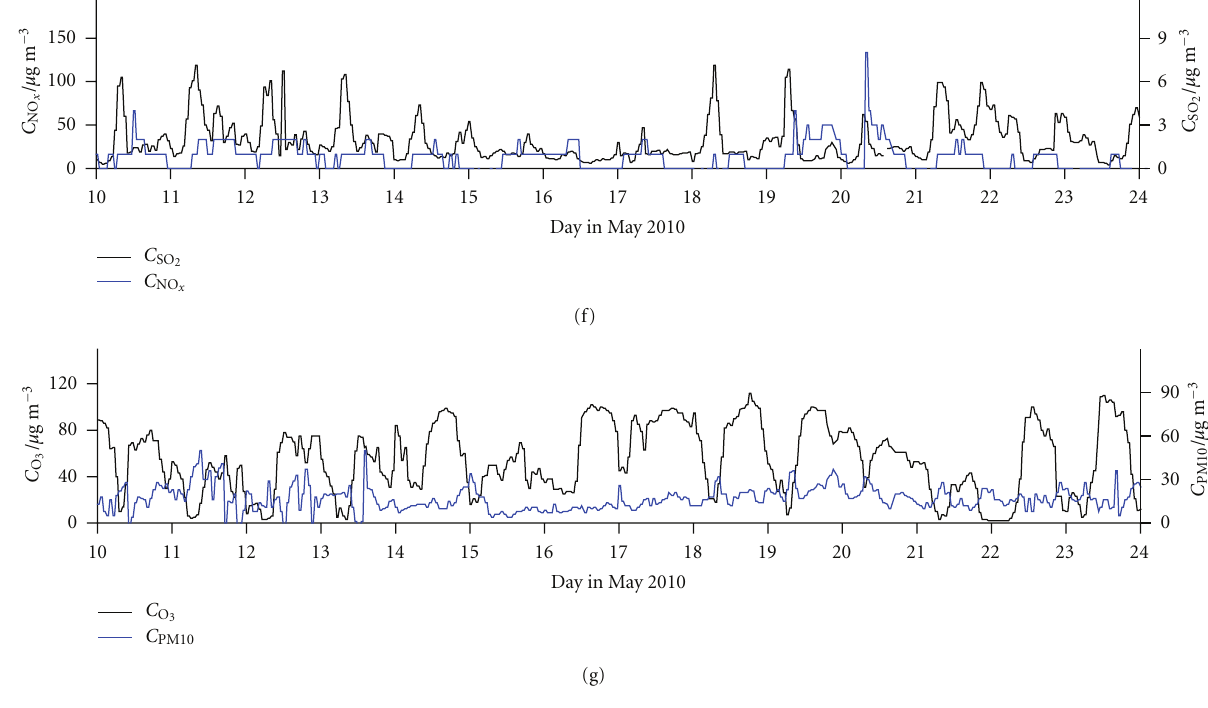
Figure 2: Time run of: (a) the total number concentration of general aerosol particles ( C N (tot)) and geometric mean of their diameters gen ( d GM ), (b) number fraction of particles smaller than 10 nm ( x gen ( < 10)) and smaller than 20 nm ( x gen ( < 20)), (c) precipitation ( h rain ) and solar radiation ( R s ), (d) air temperature ( T ) and air relative humidity ( H rel ), (e) wind velocity ( v w ) and barometric pressure ( P ), (f) concentration ), and (g) concentrations of O 3 ( C O ) and aerosol particles smaller than 10 μ m ( C PM10 ), in outdoor air in front of NO x ( C NO x ) and SO 2 ( C SO 2 3 of the dwelling for the period May 10–23,